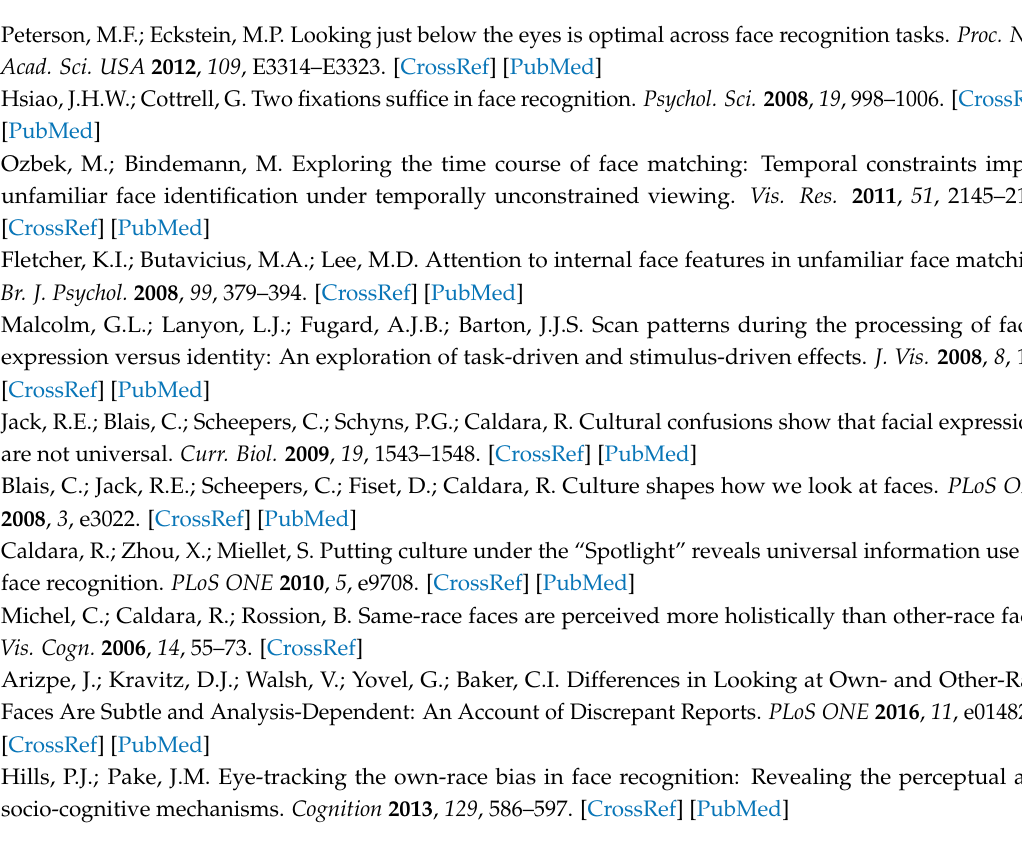
Figure S1: Fixation Durations for the First Ordinal Fixation; Figure S2: Study versus test phase vertical-profile density curves and statistical contrasts for the first ordinal fixation, separated by (A) the short presentation time condition, and (B) the short presentation time condition; Figure S3: Study versus test phase fixation density plots, difference plots, and statistical contrasts for the first ordinal fixation, separated by (A) the short presentation time condition, and (B) the long presentation time condition; Figure S4: Short versus long presentation time condition vertical-profile density curves and statistical contrasts for the first ordinal fixation, separated by (A) study phase, and (B) test phase; Figure S5: Short versus long presentation time condition vertical-profile density curves and statistical contrasts for the second ordinal fixation, separated by (A) study phase, and (B) test phase; Figure S6: Study versus test phase fixation density plots, difference plots, and statistical contrasts for the second ordinal fixation, separated by (A) the short presentation time condition, and (B) the long presentation time condition; Figure S7: Opposing conditions vertical-profile density curves and statistical contrasts for the second ordinal fixation, separated by (A) study phase, short presentation time versus test phase, long presentation time, and (B) study phase long presentation time versus test phase short presentation time; Figure S8: Consistency of Fixation Locations vs. Recognition Performance; Figure S9: Opposing conditions vertical-profile density curves and statistical contrasts for the first ordinal fixation, separated by (A) study phase, short presentation time versus test phase, long presentation time, and (B) study phase long presentation time versus test phase short presentation time; Figure S10: Study versus test phase fixation density plots, difference plots, and statistical contrasts for the third ordinal fixation, separated by (A) the short presentation time condition, and (B) the long presentation time condition, Supplementary